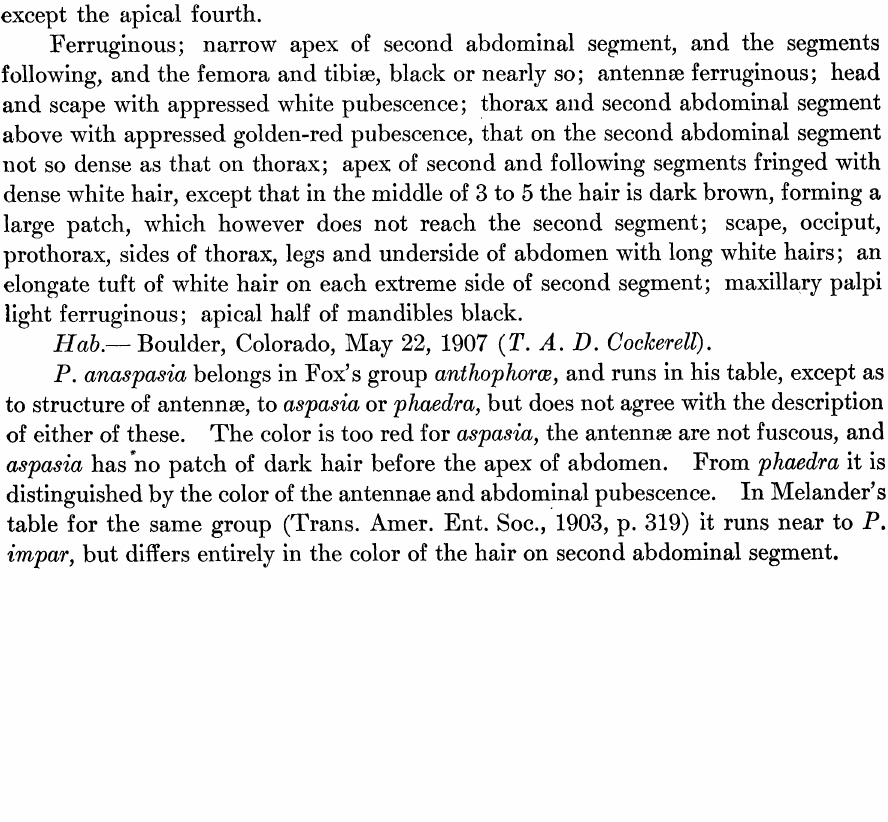
table for the same group (Trans. Amer. Ent. Soc., 1903, p. 319) it runs near to P. impar, but differs entirely in the color of the hair on second abdominal